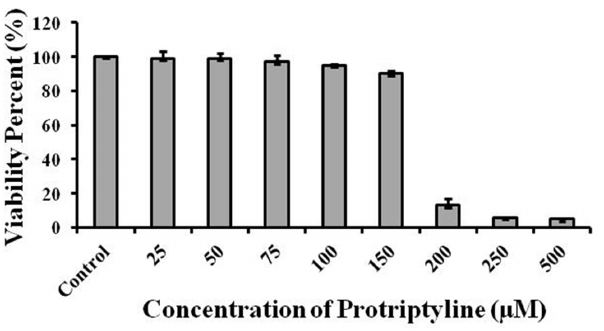
Figure 8. Cell viability in neuro2a cells. Effect of various concentrations of protriptyline (25–500 m M) on cell viability was assessed by MTT assay. Cells were 90% viable up to 150 m M protriptyline concentration.